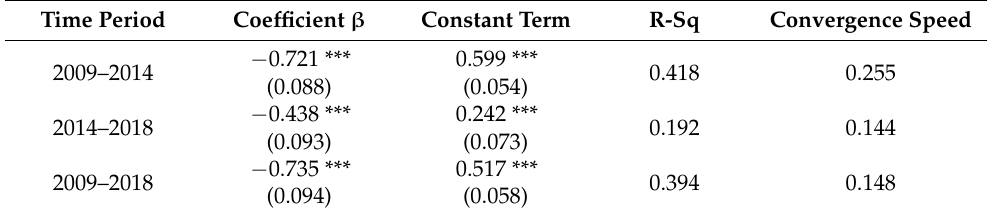
Table 3. Estimation results of absolute β